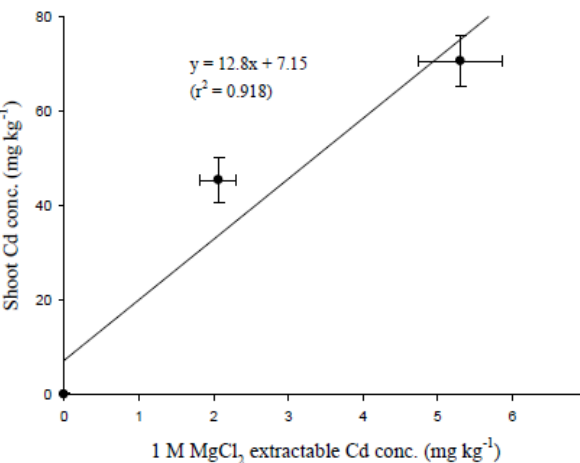
Figure 6. Linear relationship between 1 M MgCl and that accumulated in the edible parts of pak choi grown in various Cd-contaminated soils for 50 days. Replicates: n =